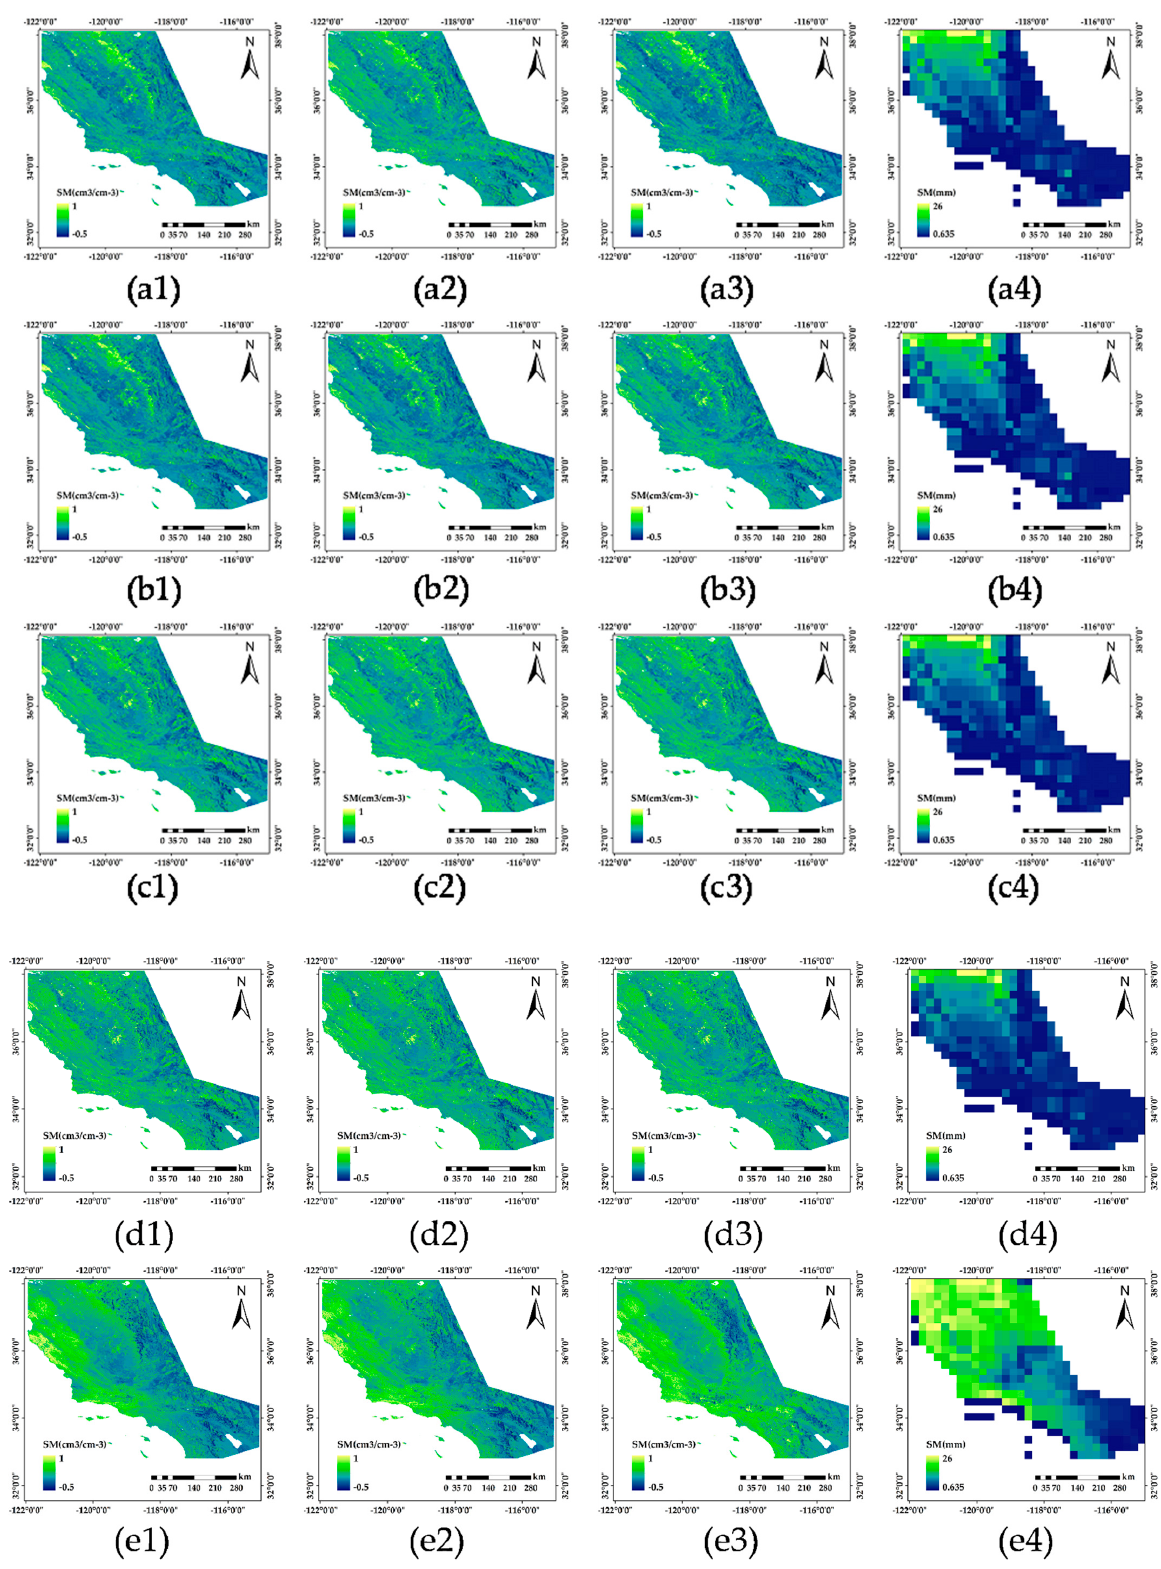
Figure 7. ( a1 – a3 , b1 – b3 , c1 – c3 , d1 – d3 , e1 – e3 ) are 15 February 2014–1 March 2014 GA-BP inverted soil moisture map for 15 consecutive days during the period, ( a4 , b4 , c4 , d4 , e4 ) correspond to the NASA-USDA soil moisture during the period 15 February 2014–1 March 2014 In the picture, the time resolution of NASA products is 3 days, so there are only 5 soil moisture maps in 15 days, one every three days. Blank areas were removed as ancillary data for water body impact